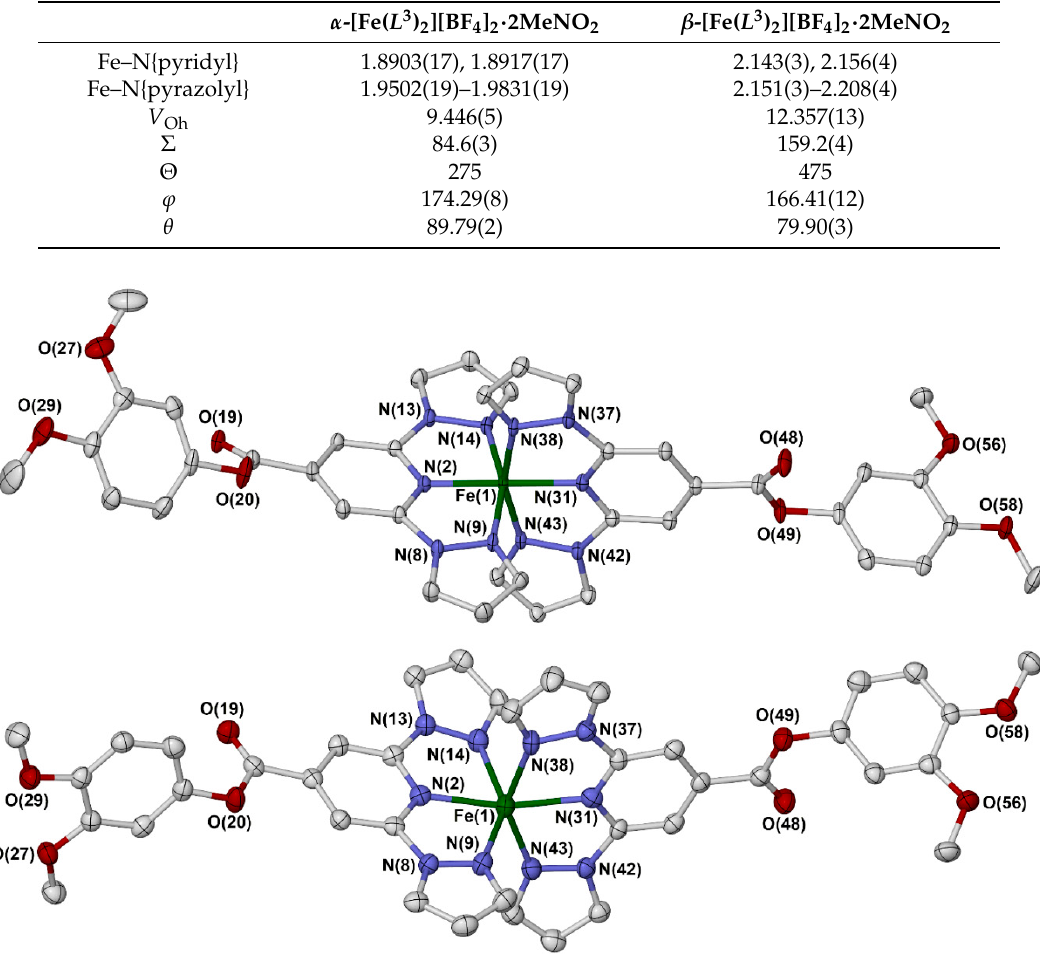
Figure 1. View of the complex dications in the low-spin α -polymorph (top) and high-spin β -polymorph (bottom) of β -[Fe( L 3 ) 2 ][BF 4 ] 2 ·2MeNO 2 . Displacement ellipsoids are at the 50% probability level, and H atoms are omitted. Colour code: C, white; Fe, green; N, blue; O, red. Solvent-free crystals of [Fe( L 4 ) 2 ][BF 4 ] 2 , and acetonitrile solvates of [Fe( L 5 ) 2 ][BF 4 ] 2 and